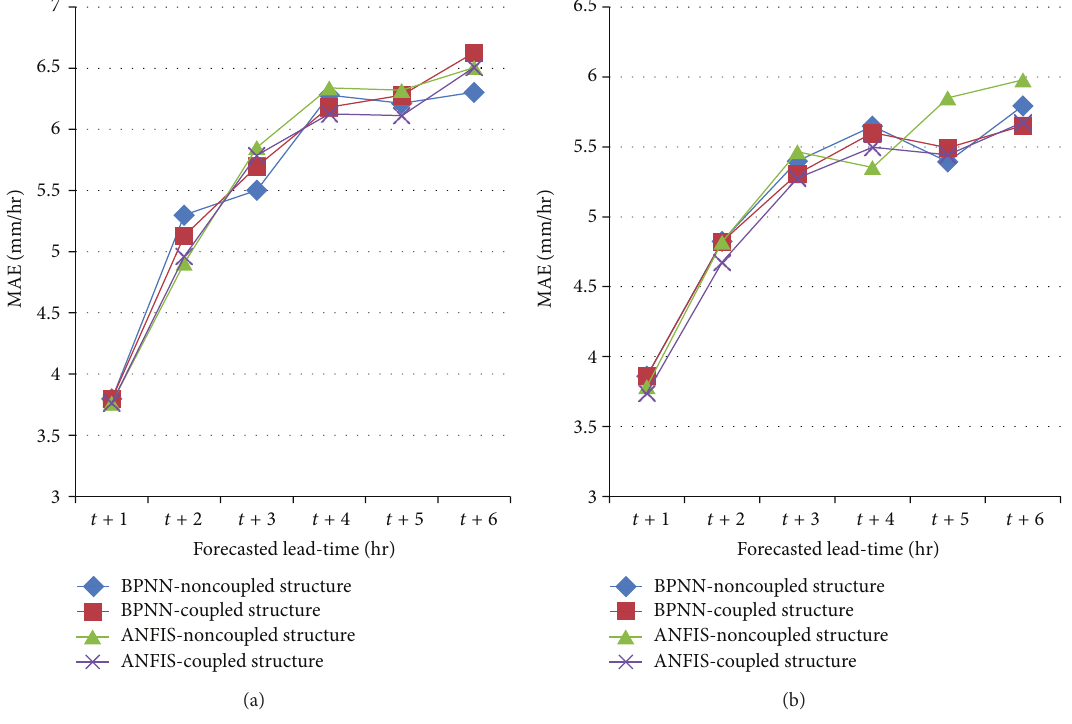
Figure 13: The validation MAE values of the models at multiple forecast lead-times: (a)Yu-Feng station; (b) Hsia-Yun station.